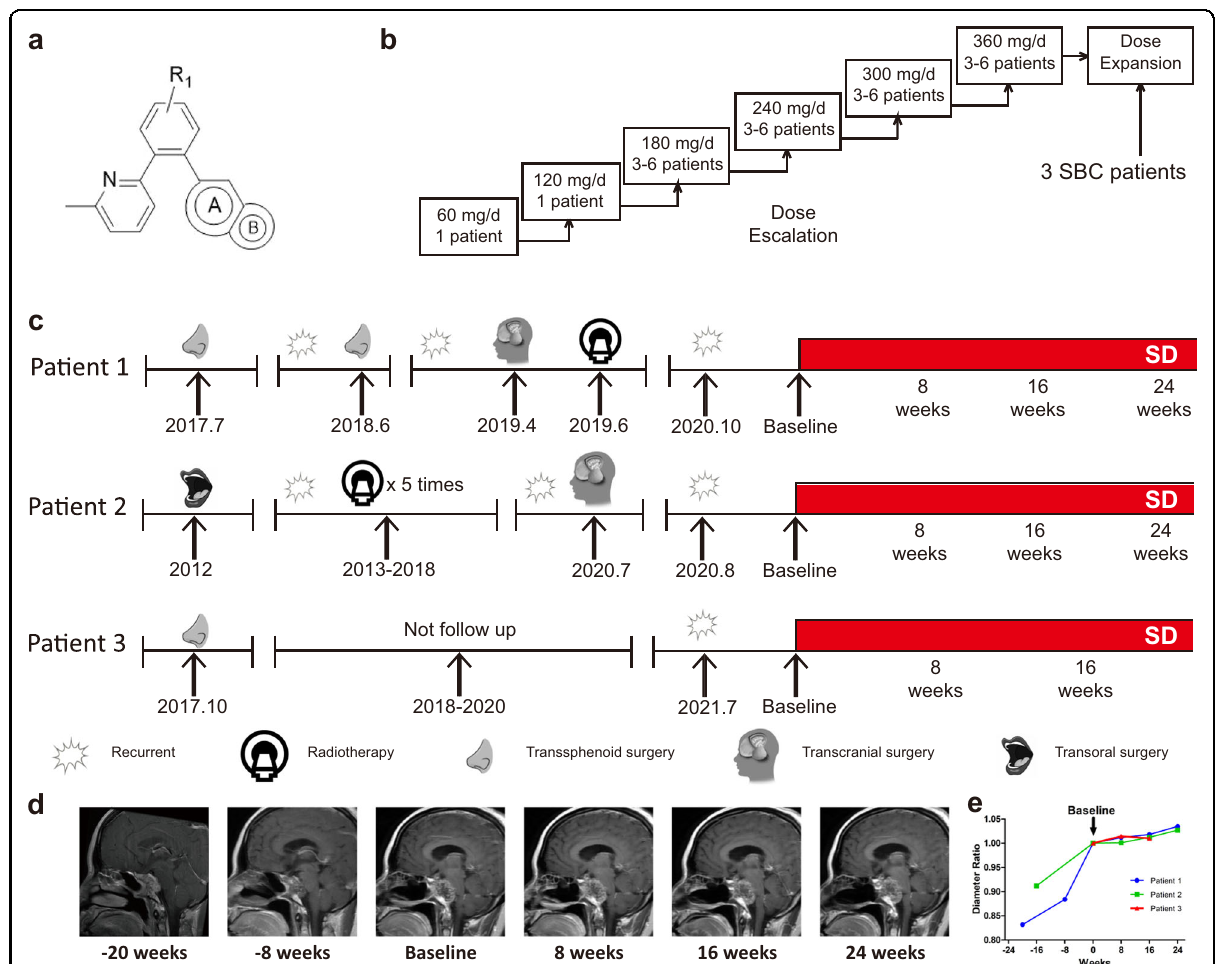
Fig. 7 Clinical trial of YL-13027 in three human SBC patients. a The chemical structure of YL-13027, a distinct chemical entity as a TGF- β R1 inhibitor. b The design of the phase I dose-escalation and dose-expansion study of YL-13027. The starting dose was 60 mg/day and then increased to 120, 180, 240, 300, and 360 mg/day. At each dosage over 120 mg/day, a cohort of 3 – 6 patients were enrolled, and the dose-limiting toxicities (DLTs) were evaluated within the fi rst 4 weeks of drug administration. Three SBC patients were enrolled at a dose of 360 mg/day. No DLT was observed in these three patients. One patient experienced transient rash in both the knee and abdomen. c Diagram of SBC progression and treatment in three patients. The tumor was con fi rmed to recur locally and progressed rapidly. Up to the cutoff date, all patients achieved stable disease. d The tumor (Patient 1) was monitored by MRI evaluation. e SBC obviously progressed before enrollment and stabilized after the administration of